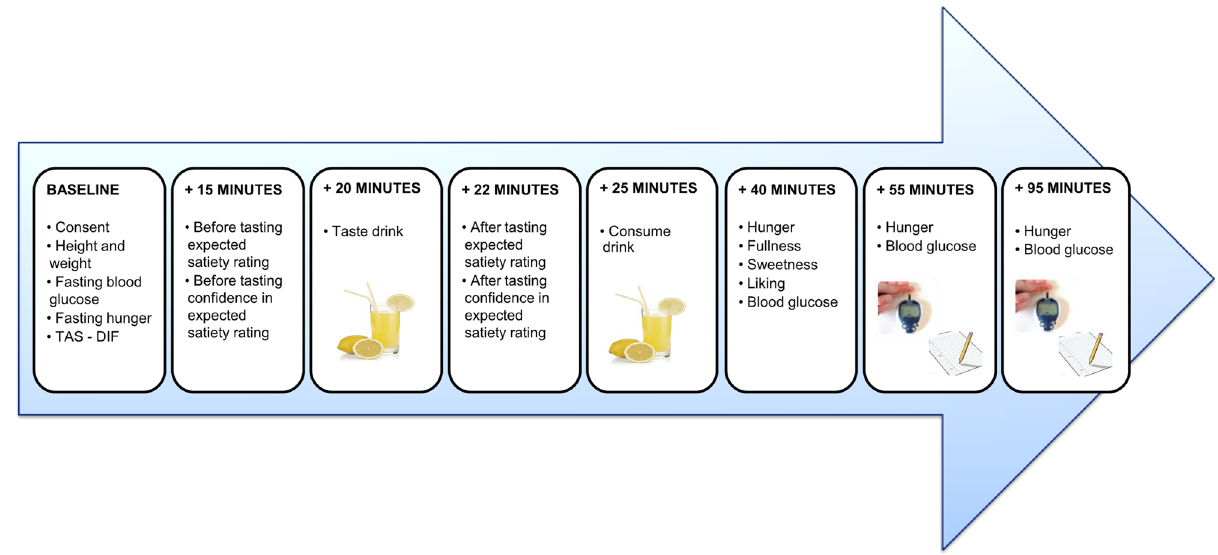
Figure 2. The experimental procedure. TAS Toronto Alexithymia Scale, DIF difficulty identifying